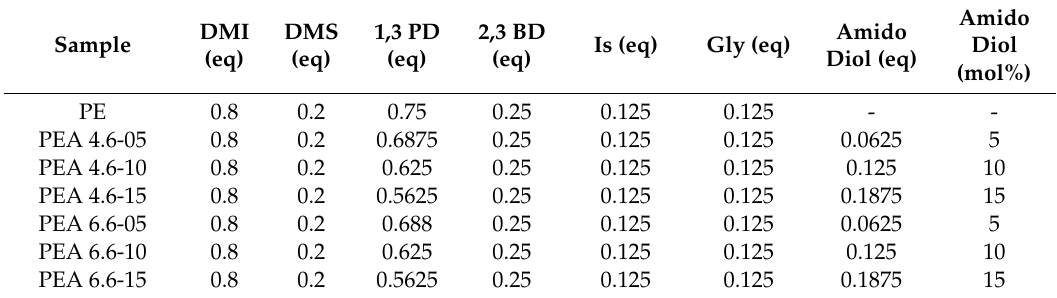
Table 1. Composition of the unsaturated neat polyester and poly(ester amide) resins synthesized. DMI: dimethyl itaconate, DMS: dimethyl